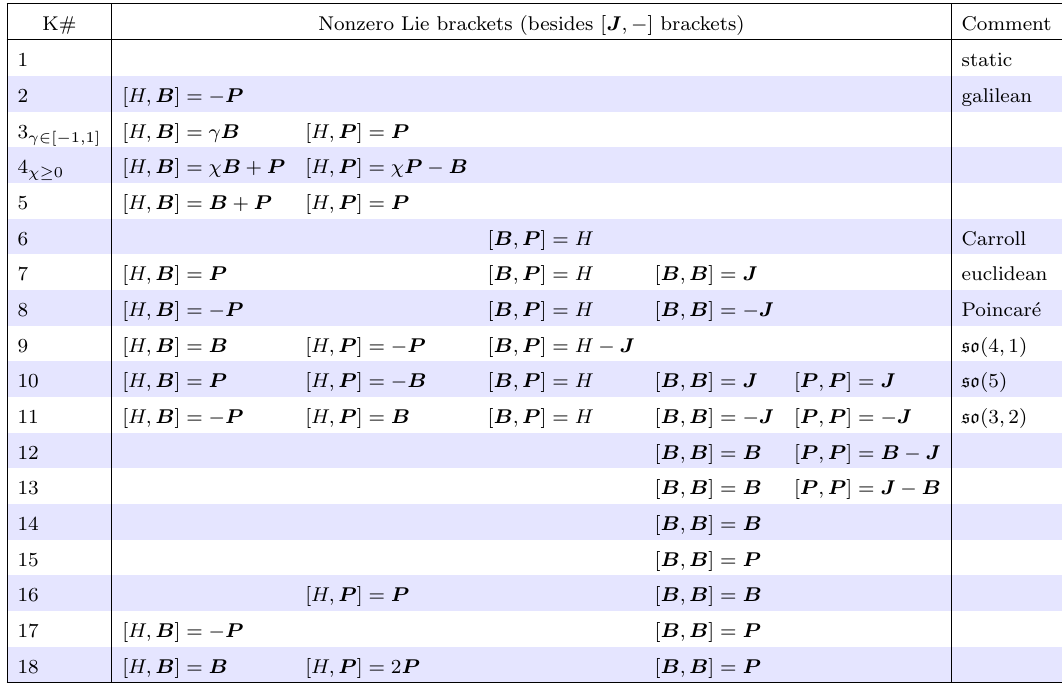
Table 2 . Kinematical Lie